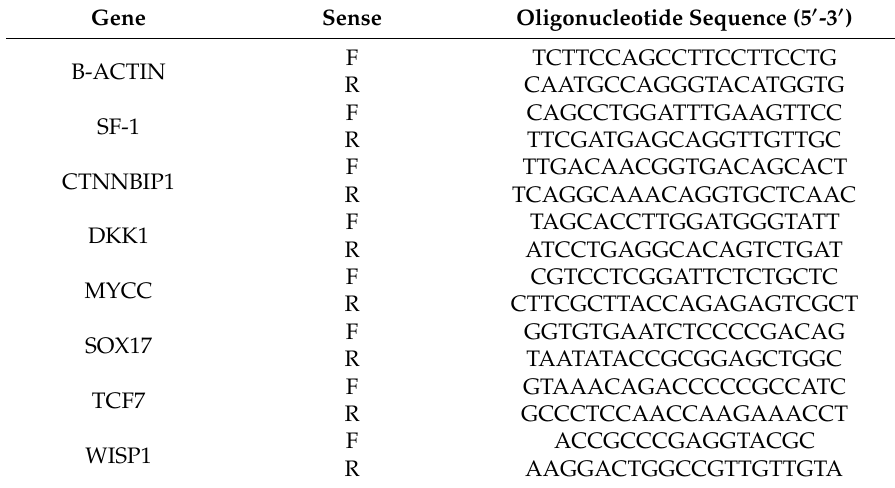
Table 3. Sequences of oligonucleotide primers for